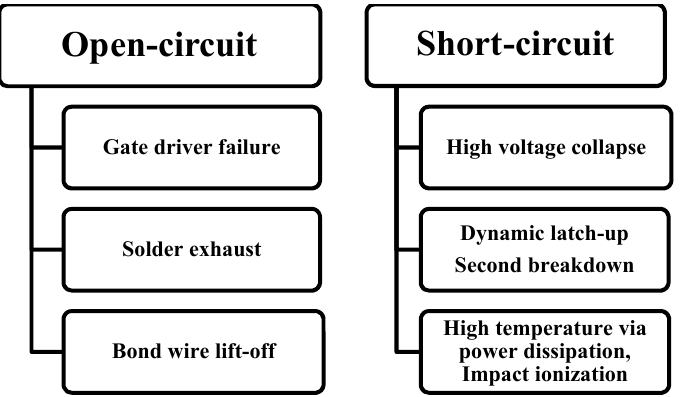
Figure 7. Common catastrophic failures of IGBT.